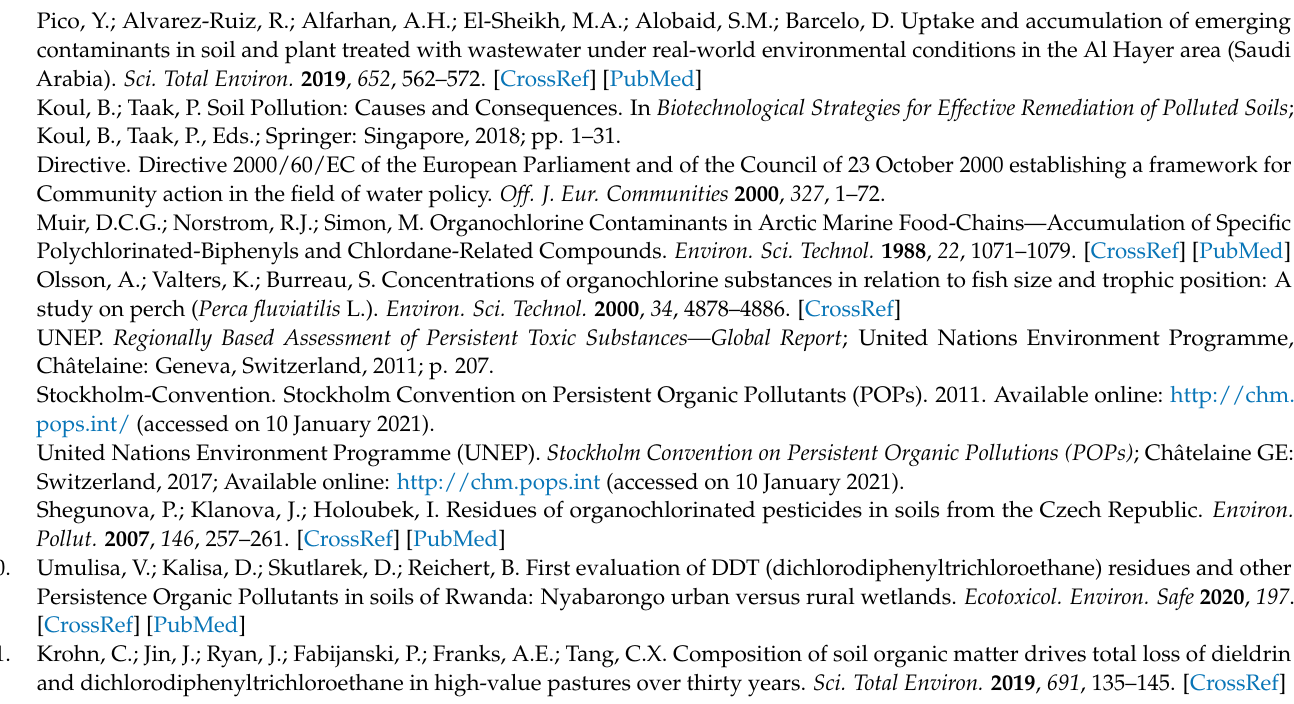
Table S1: Parameters used in exposure cancer and no-cancer risk assessments, Table S2: Dieldrin PECsoil (mg/kg) values in the range of 0–20,000 days, after